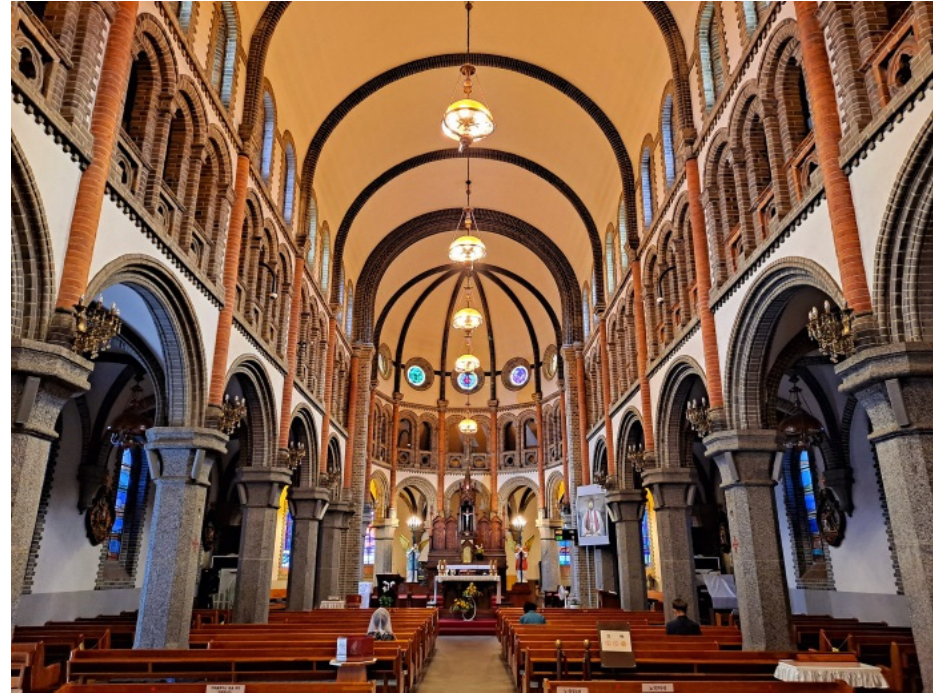
Figure 8. Interior image of Jeonju Jeondong Catholic Church [source: photo by author].